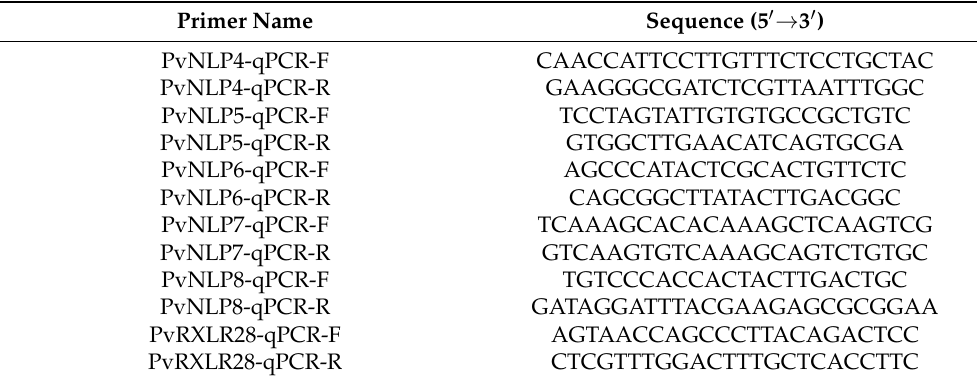
Table 2. Oligonucleotides used for qPCR.